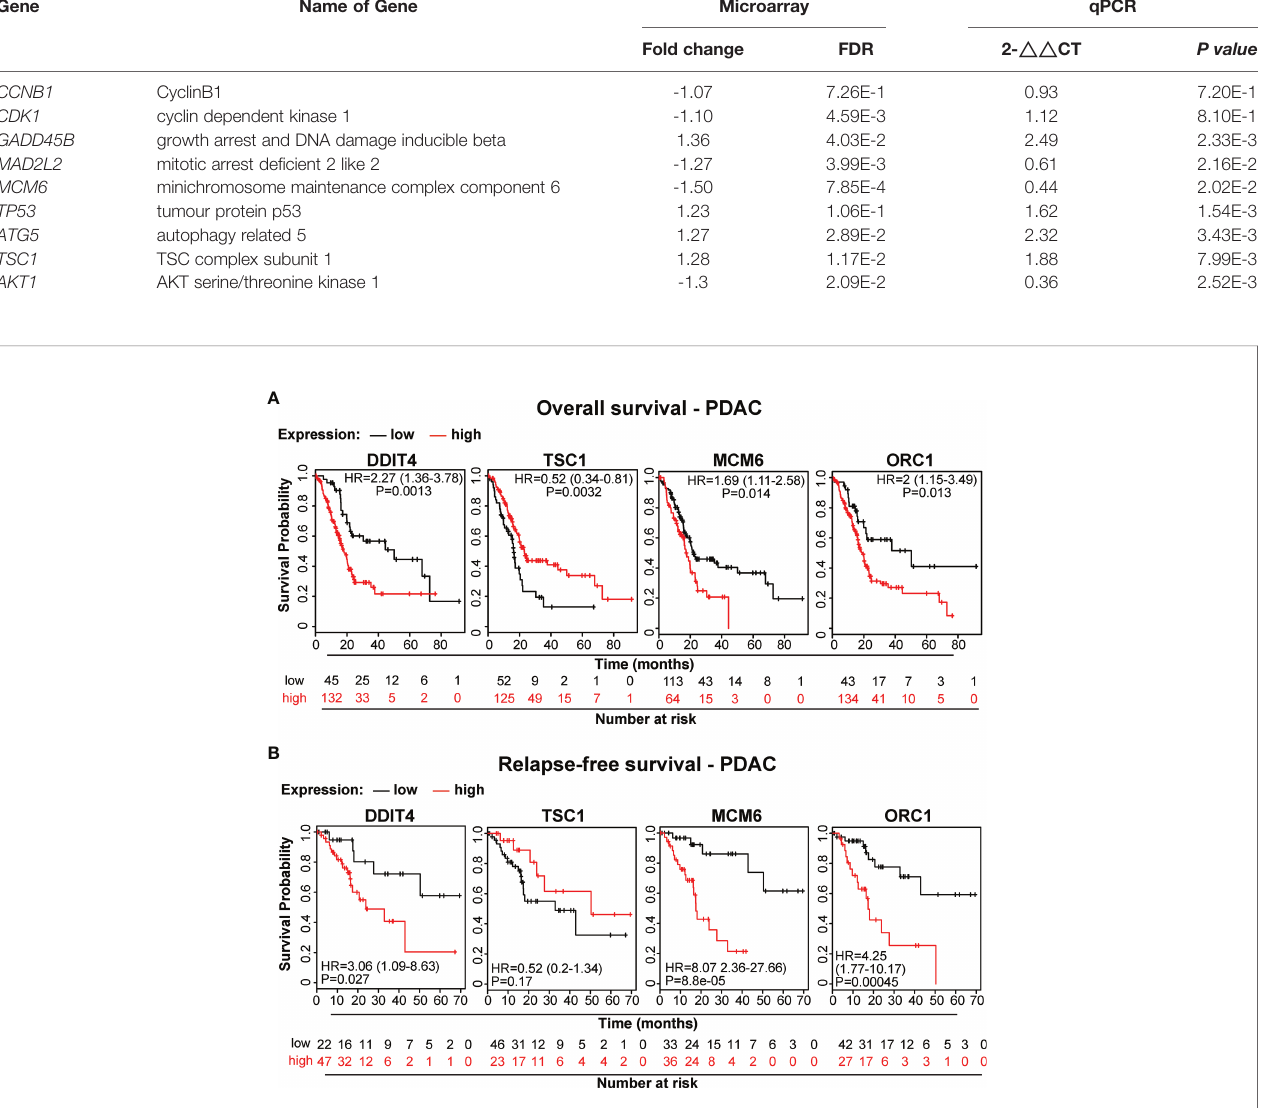
FIGURE 7 | The expression levels of the candidate genes MCM6, ORC1, DITT4 and TSC1 correlate to overall and relapse-free survival in PDAC. (A) We searched the online database TCGA for existing data of the identi fi ed target genes and found PDAC-related expression and clinical data for MCM6 , ORC1 , DITT4 and TSC1. Using these online data, we performed Kaplan-Meier analysis of overall survival and (B) relapse-free survival in relation to gene expression (data from TCGA-PAAD, pH 000178, N = 185). HR, Hazard ratio and the signi fi cance P are